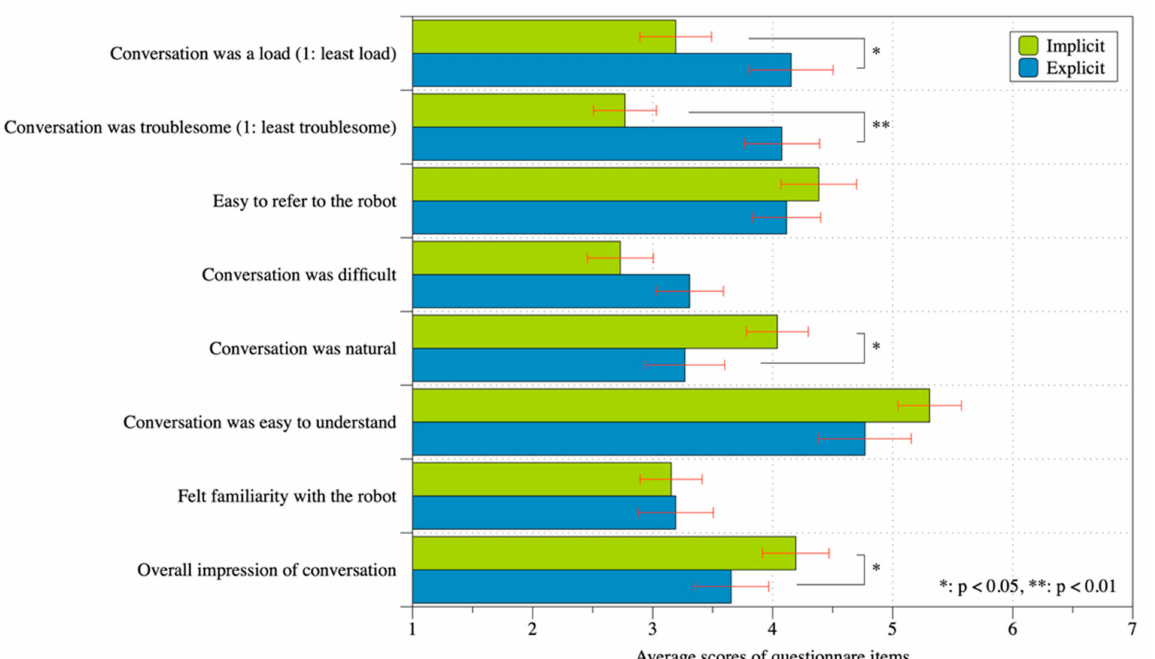
Figure 14. Performance of object reference recognition with standard error of Experiment 2.